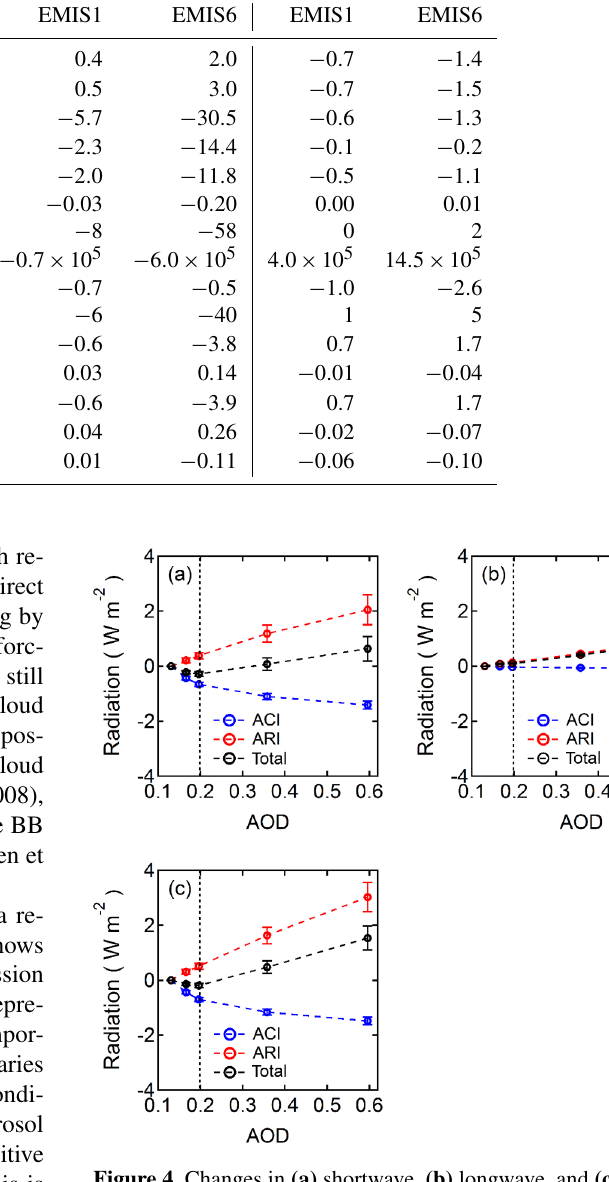
Figure 4. Changes in (a) shortwave, (b) longwave, and (c) total ra- diation budgets at TOA with increasing BB emission intensity (in- dicated by domain-averaged AOD in each emission scenario). The vertical dotted line in each plot indicates the EMIS1 scenario. Error bars denote the standard